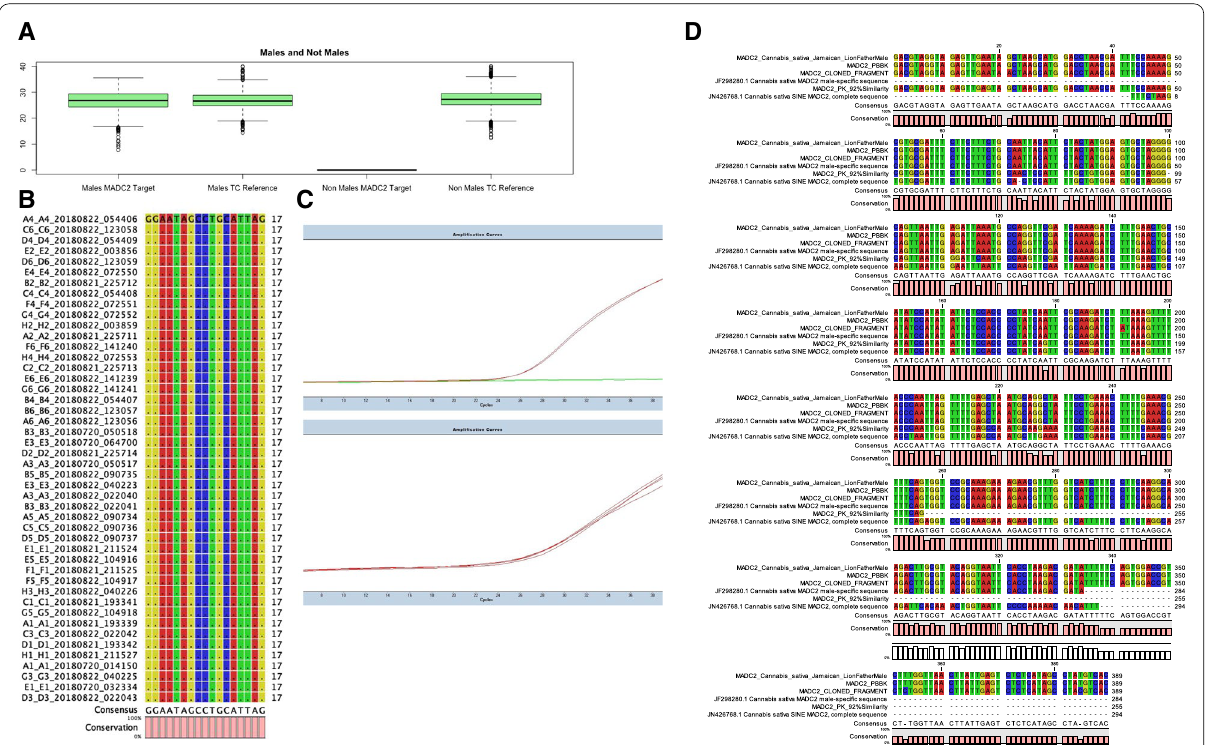
Fig. 1 Male plant sex marker analysis by qPCR and sequencing. A Box plot analysis of 2nd derivative cycle quotient values for MADC2 and tissue control for 8200 samples from SexID qPCR results. B Genetic alignment of Steep Hill TaqMan probe for male identification from targeted sequencing of 45 males. C Representative amplification plots for Steep Hill sex determination assay (top: MADC2 amplification plot) (bottom: tissue control amplification plot). D Genetic alignment of canonical MADC2 391-bp cloned fragment from Mandolino aligned to queried IDs in PacBio sequence from Pineapple Banana Bubba